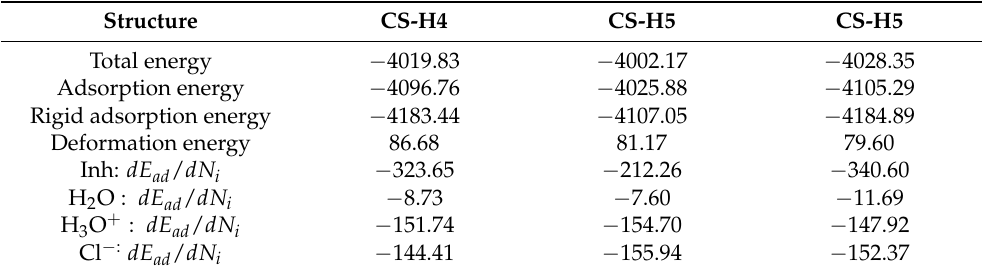
Table 3. Simulation results (total energy, adsorption energy, rigid absorption energy, and deformation energies) in acid solutions (Fouda et al., 2021)